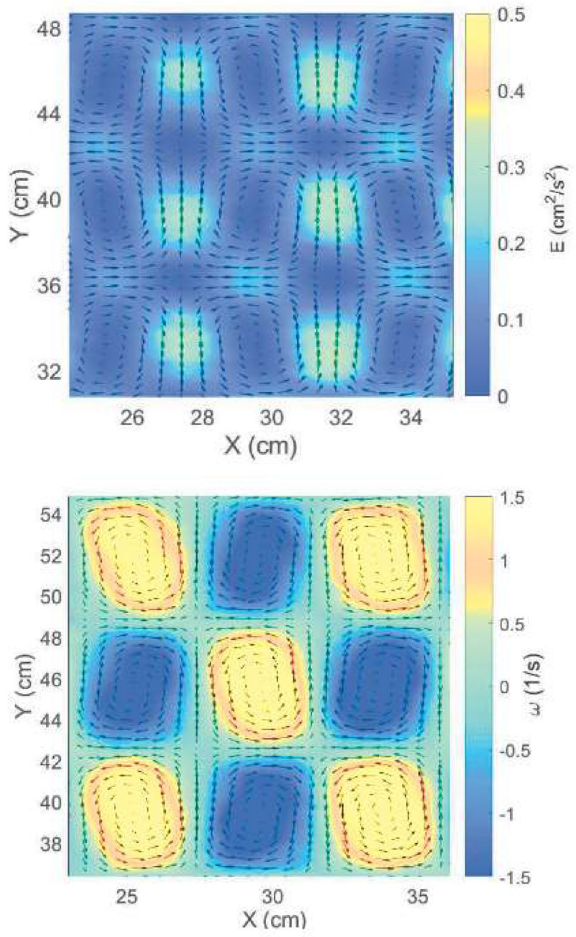
Figure 5. Time averaged velocity field overlapped to kinetic energy (top) and vorticity (bottom) maps for the 0.08 Hz. Velocity data are interpolated on a 128 2 A, I ′ 1 A, f set up: I = = =